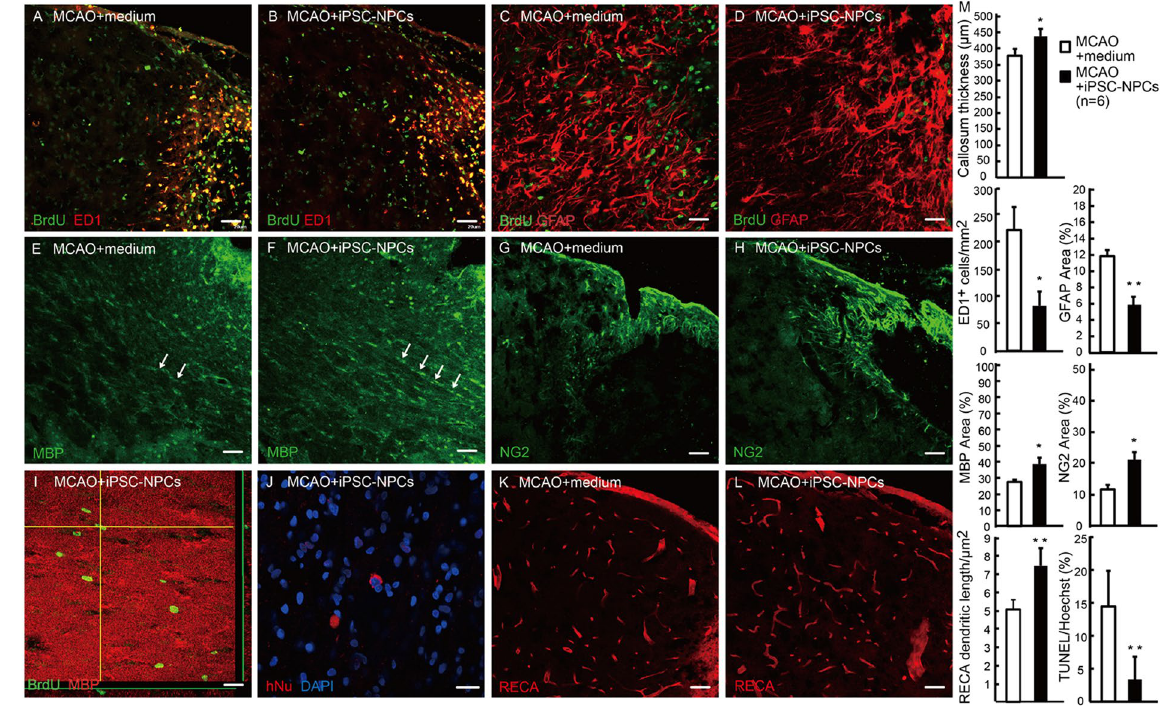
Figure 3. Epidural iPSC-NPCs grafts ameliorated inflammation and astrogliosis, and augmented endogenous oligodendrocyte progenitor cells, white matter tract integrity, and angiogenesis. Immunohistochemistry at 21 days post-transplantation. ( A , B ) In the peri-infarct cortex, labeled as p, p’ in Fig. 2A, BrdU-labeled cells were mainly identified as ED1-immunoreactive microglia, macrophages or hematogenous monocytes, and to a lesser extent, astrocytes ( C , D ) and oligodendrocytes ( I ). The inflammatory infiltration was significantly ameliorated in the iPSC-NPC group ( M ), as was the GFAP-immunoreactive astrogliosis ( C , D , M ). ( E , F ) Moreover, in the iPSC-NPC group, myelination (MBP-immunoreactive oligodendrocytes) in the paramedium corpus callosum, labeled as c, c’ in Fig. 2A, was better preserved ( M ), and some endogenous nascent oligodendrocytes were observed by BrdU-pulse labeling ( I ). NG2-positive oligodendrocyte progenitors were robustly increased in the penumbra in the iPSC-NPC group ( G , H , M ). Few exogenous human nuclei-positive cells migrated and survived in the peri-infarct cortex following an epidural transplantation ( J ). There was also increased RECA-positive endothelial vasculature in the peri-infarct cortex of the cell-transplanted brain ( K , L , M ). ( M ) Between-group comparisons of immunohistochemical quantifications. Scale bar ( A , B , E–H , K , L ) = 50 µ m; ( C , D ) = 25 µ m; ( I , J ) = 10 µ m. * P < 0.05; ** P <